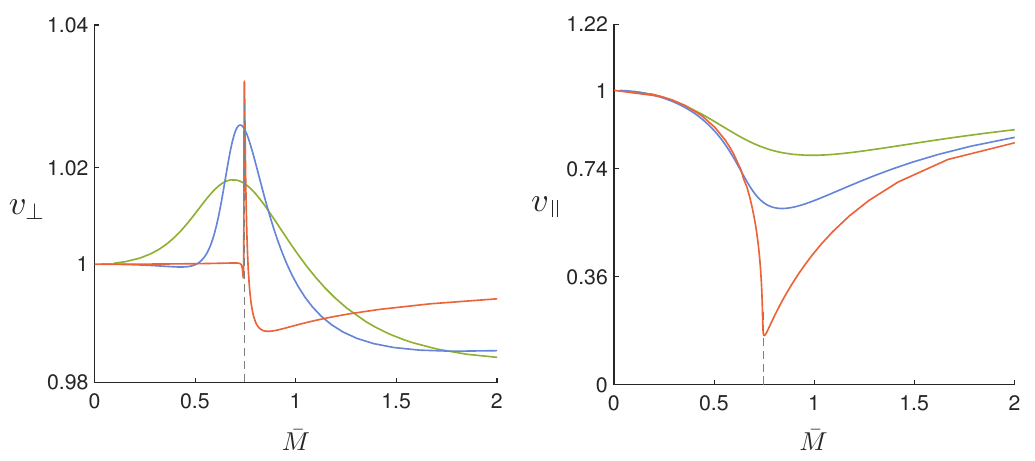
Figure 6. Butter(cid:13)y velocities as function of dimensionless mass (cid:22) M , for various temperatures (cid:22) T = 0 : 1 ; 0 : 05 ; 0 : 005 (from green to orange). The grid-line is drawn at (cid:22) M c ’ 0 : 74 in order to show the QCP. As one lowers the temperature the behavior of v B s near the critical point becomes increasingly non-analytic. Note the longitudinal (w.r.t. anisotropy direction) butter(cid:13)y velocity behaves exactly opposite to its maximization observed in [1]. The v B values have been normalized p by their asymptotic values at (cid:22) M = 0, that is, 2 = 6. This is obtained from eq. (3.5), and is equal to the bound in [36], v 2 = ( D + 1) = 2 D , which is clearly violated 2 by v ? at larger (cid:22) M B